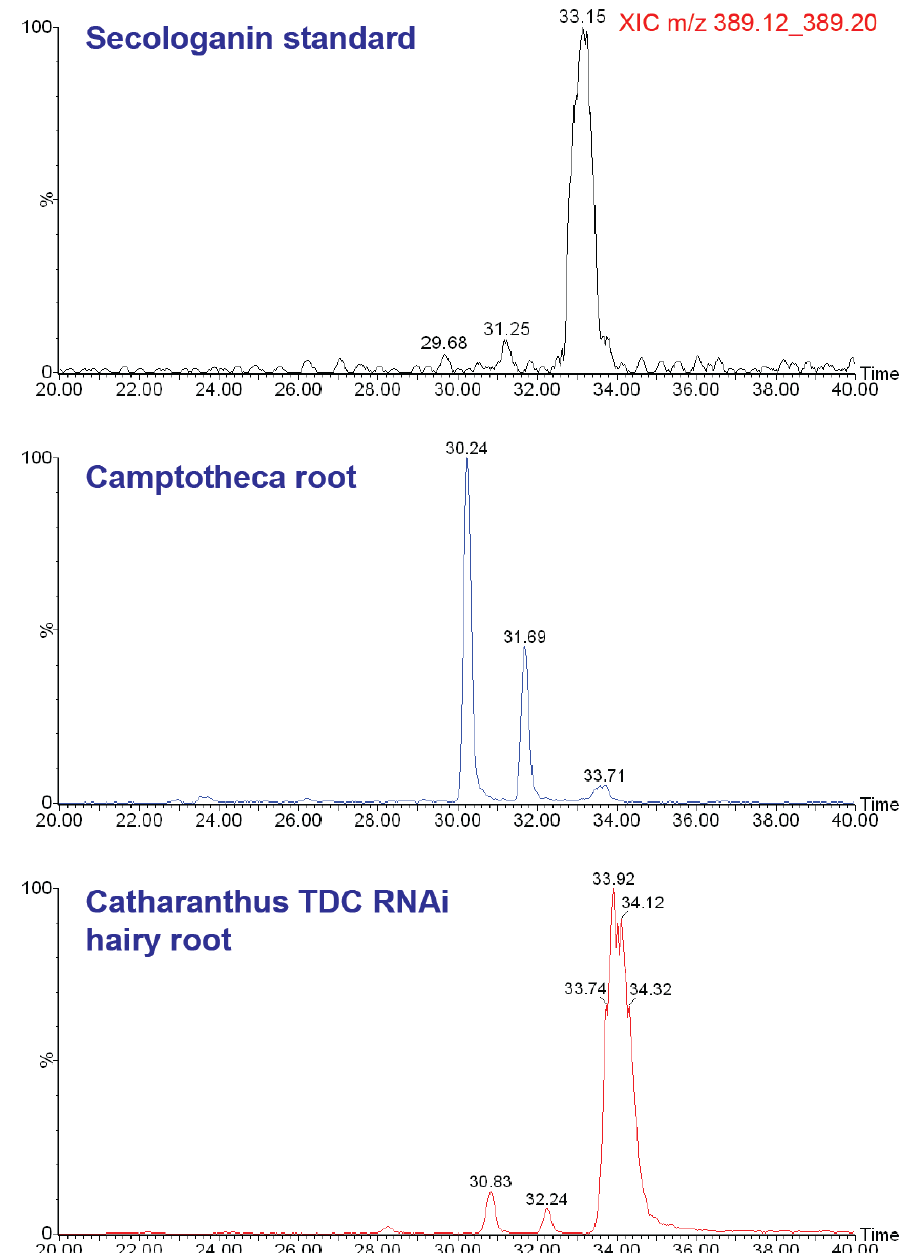
Figure 5. Extracted ion LC/MS chromatograms of [M+H] + for (top) authentic secologanin standard, (middle) C. acuminata root extract, and (bottom) C. roseus RNA interference line of hairy root culture. The third peak in the latter two corresponds with secologanin, whereas the two earlier eluting peaks (in both C. acuminata and C. roseus ) are isomers indistinguishable from molecular or fragment